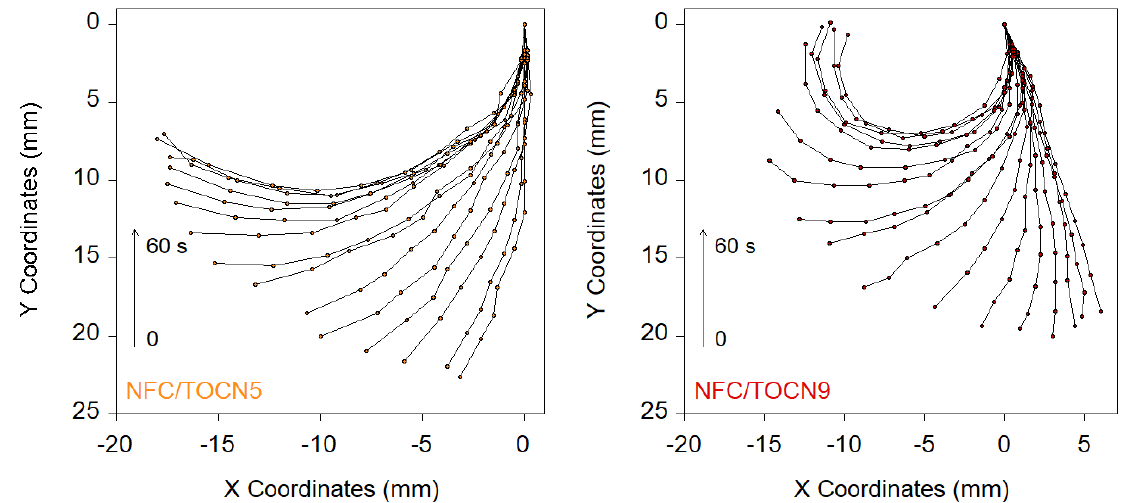
Figure 3. X-Y coordinate plots showing the evolution of the bending of NFC/TOCN nanopapers when they were immersed in high pH aqueous solutions (pH 13) for times from 0 to 60 s.